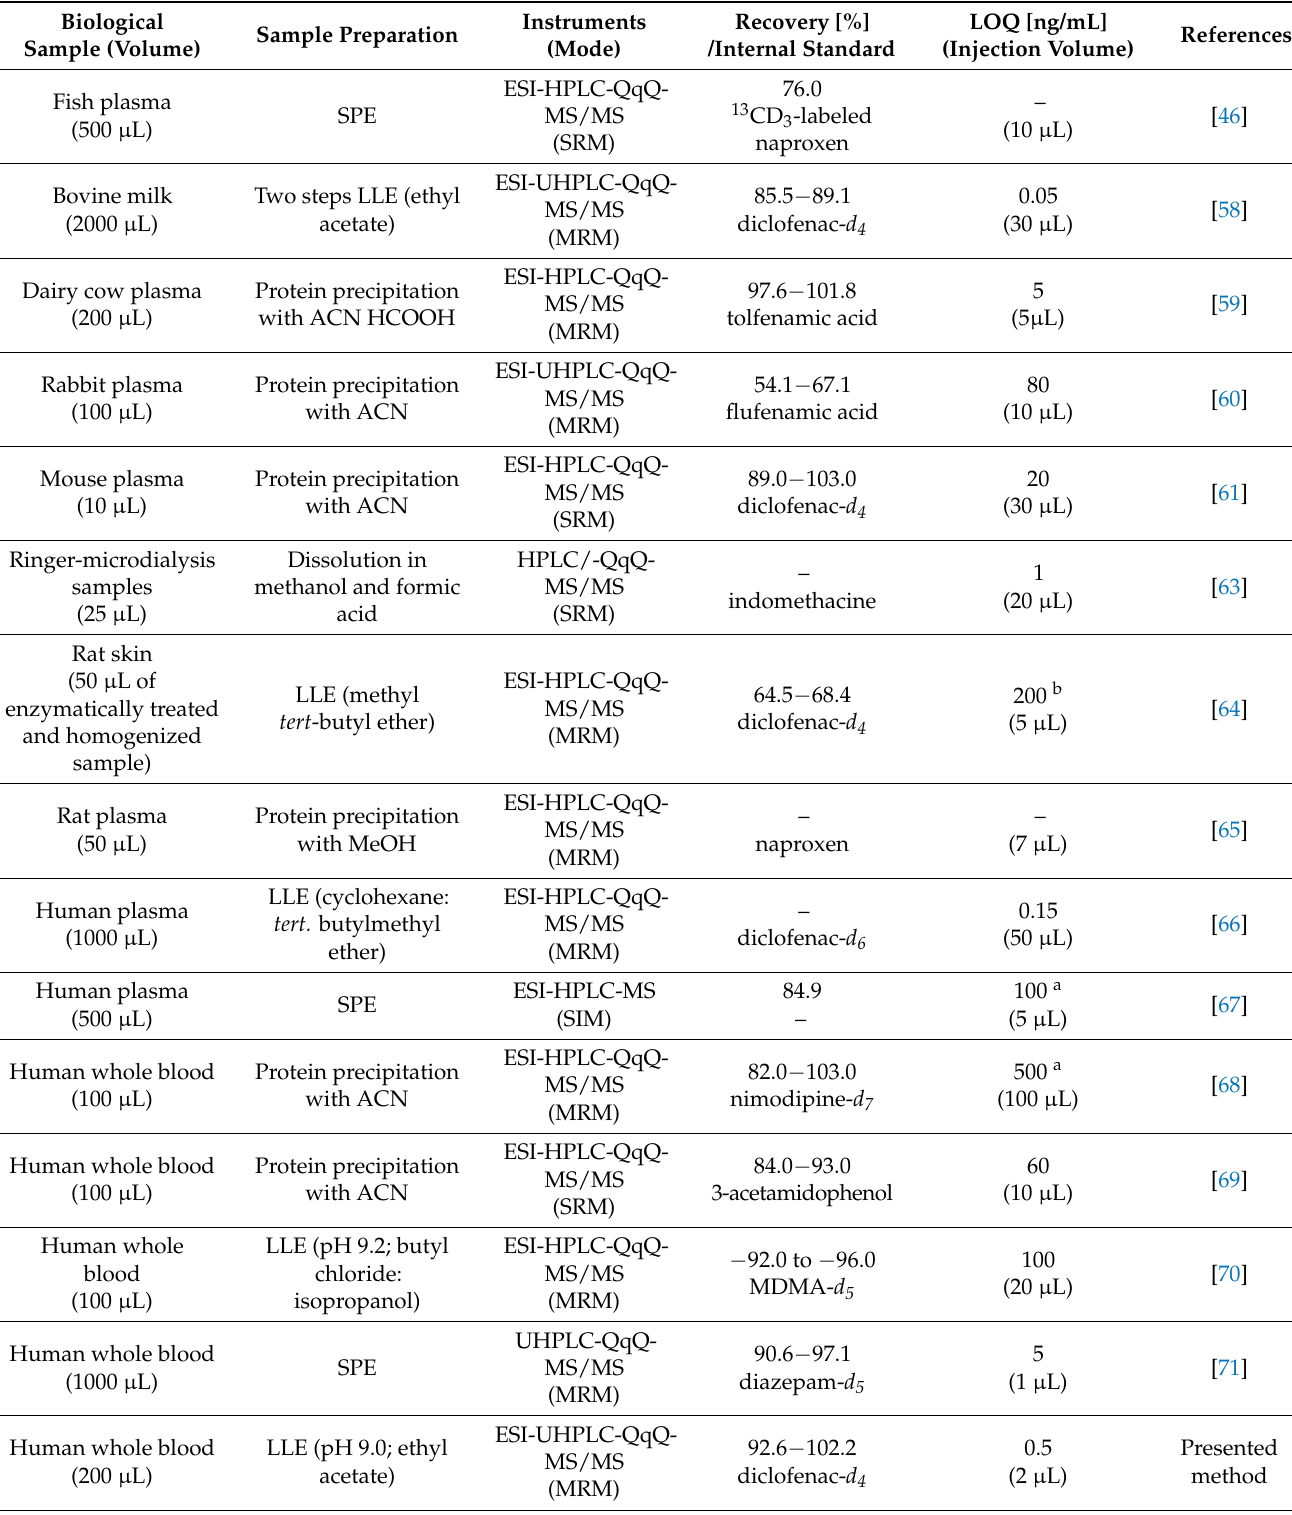
Table 4. Comparison of LC-MS methods for determination of diclofenac in biological